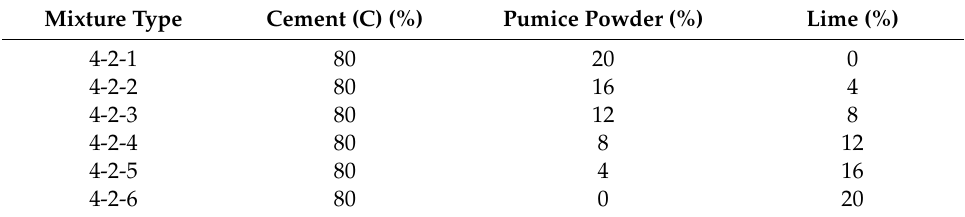
Table 8. Type-4-2 mixing ratios.